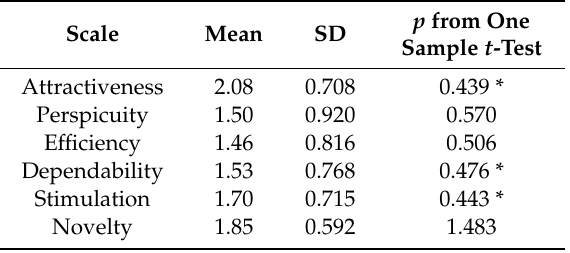
Table 1. Ratings of the participants on the user experience questionnaire (UEQ) scale. One sample of t -tests compared the mean scores to the neutral point of the scale. Statistically significant items are marked with an